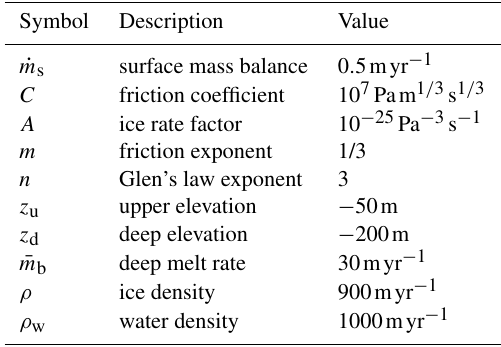
Table 2. Constants and parameters used along the numerical exper- iments.